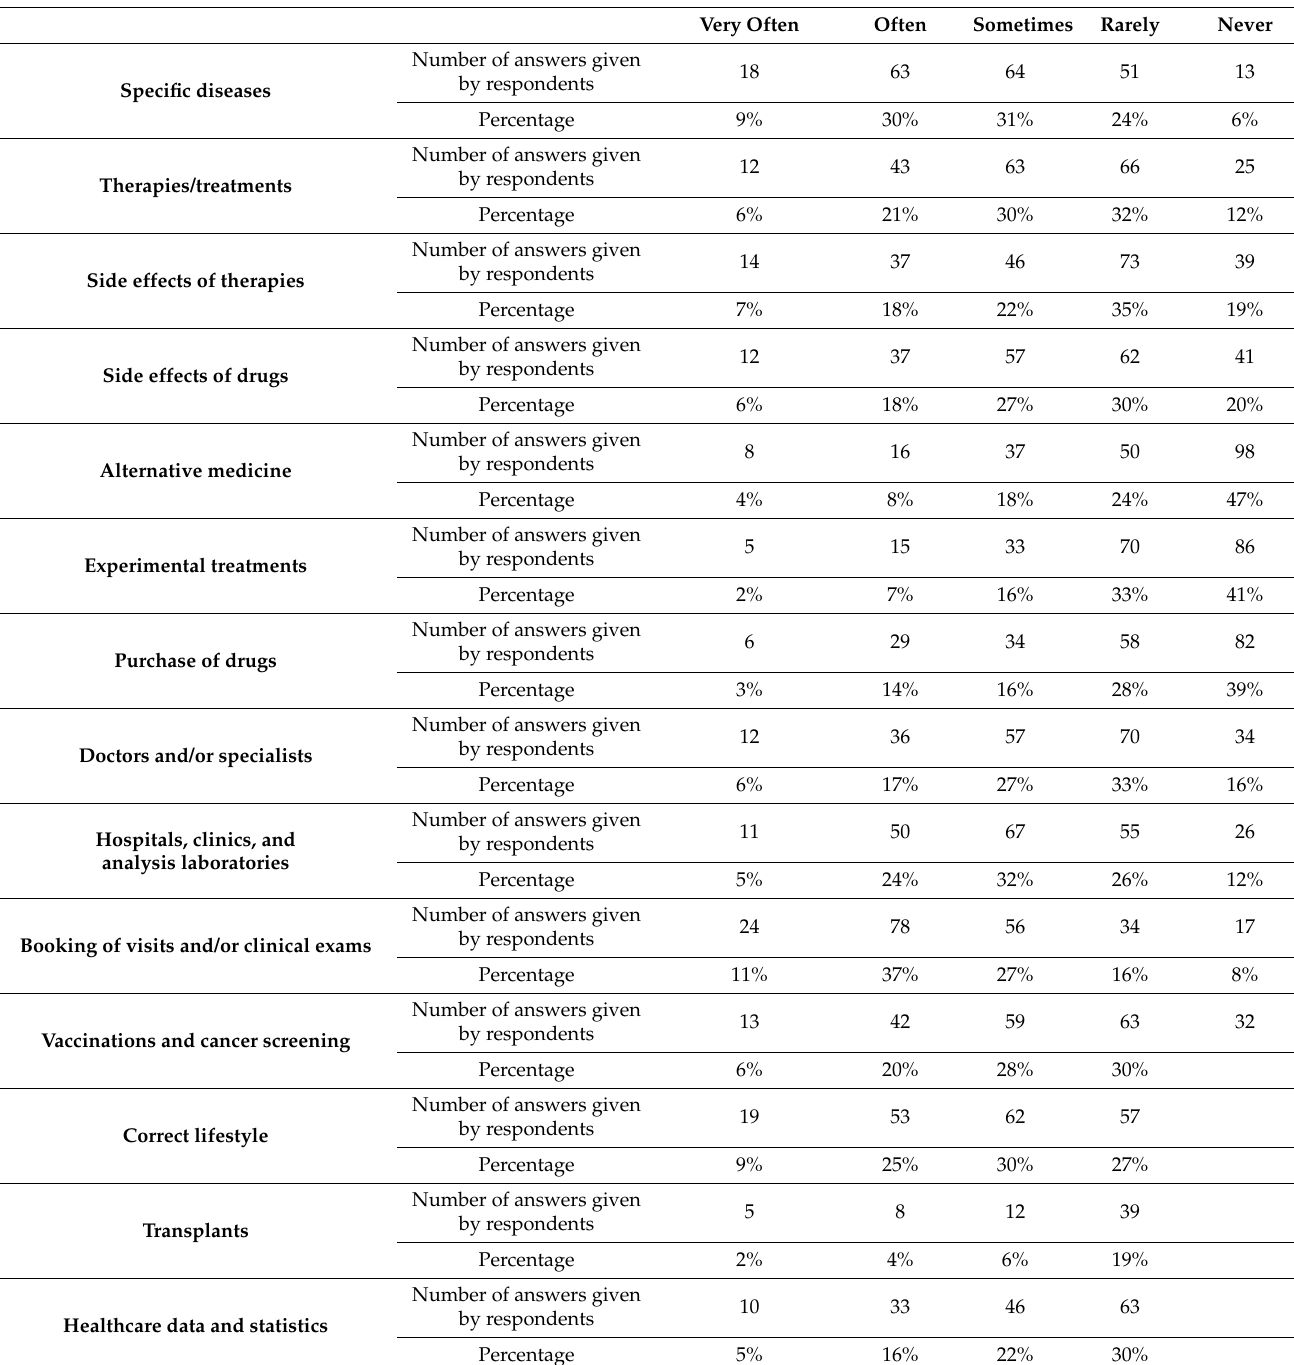
Table 4. Kinds of searched online health